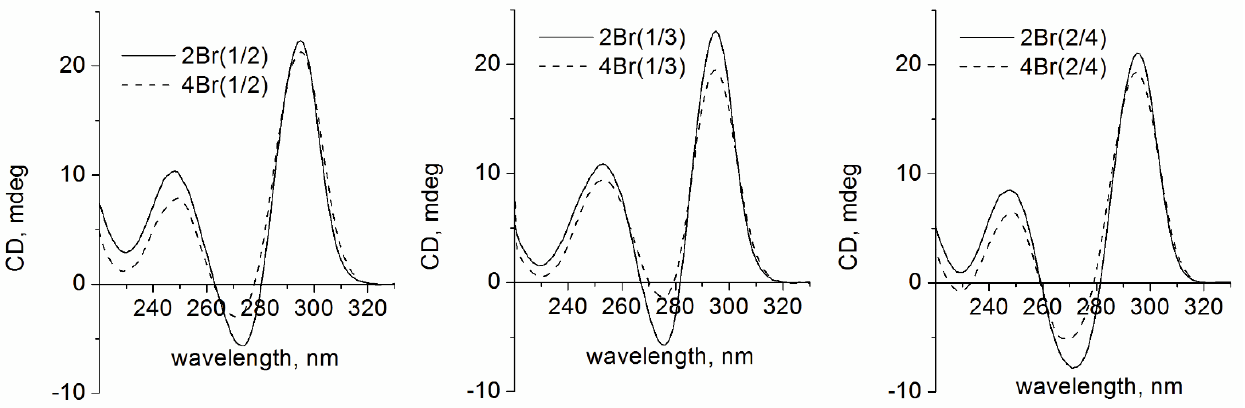
Figure 2. CD spectra of the Br-dG-modified aptamers at 20 °C in 10 mM sodium cacodylate (pH 7.2) and 100 mM KCl.